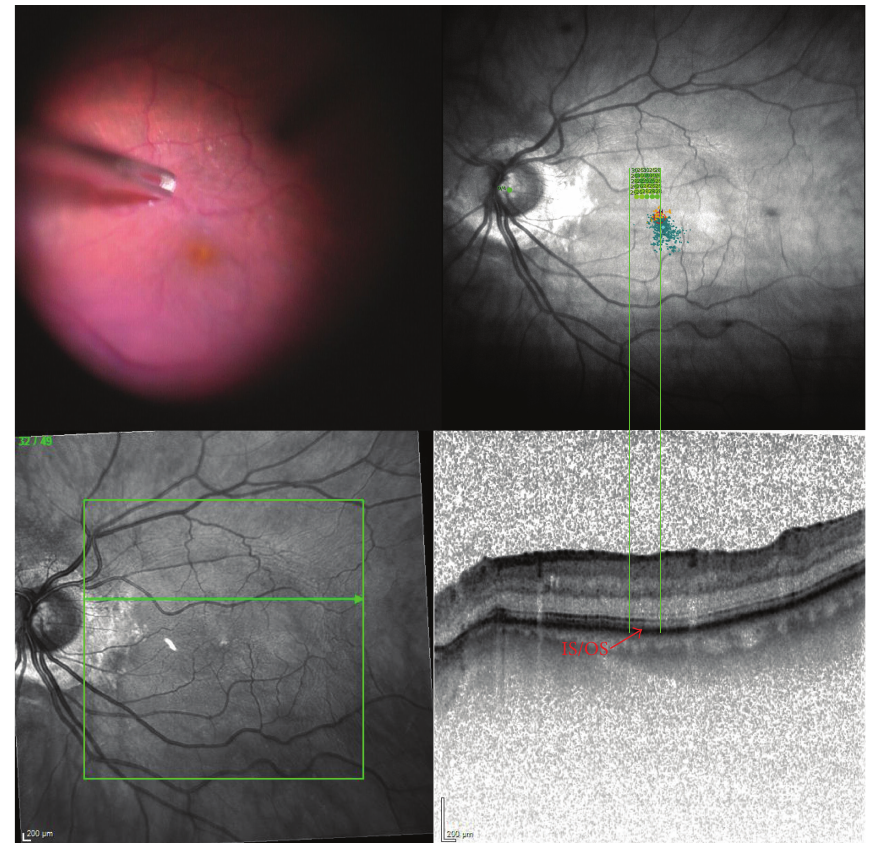
Figure1:ExampleforapostoperativeevaluationofapeelingareausingmicroperimetryanalysisandamatchingSD-OCTscan:theintegrated photoreceptor junction (IS/OS/ellipsoid zone, bottom right) correlates with a stable retinal sensitivity in this area (green microperimetry field, top